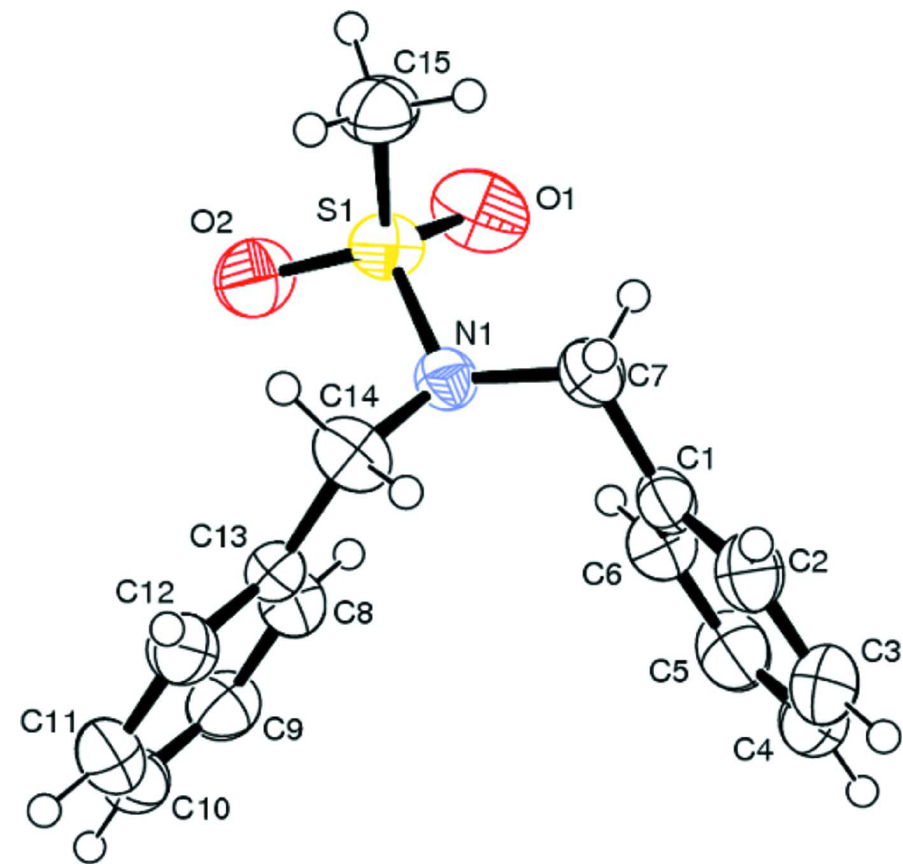
Figure 1 Molecular structure of (I), with atom labels and 50% probability displacement ellipsoids for non-H